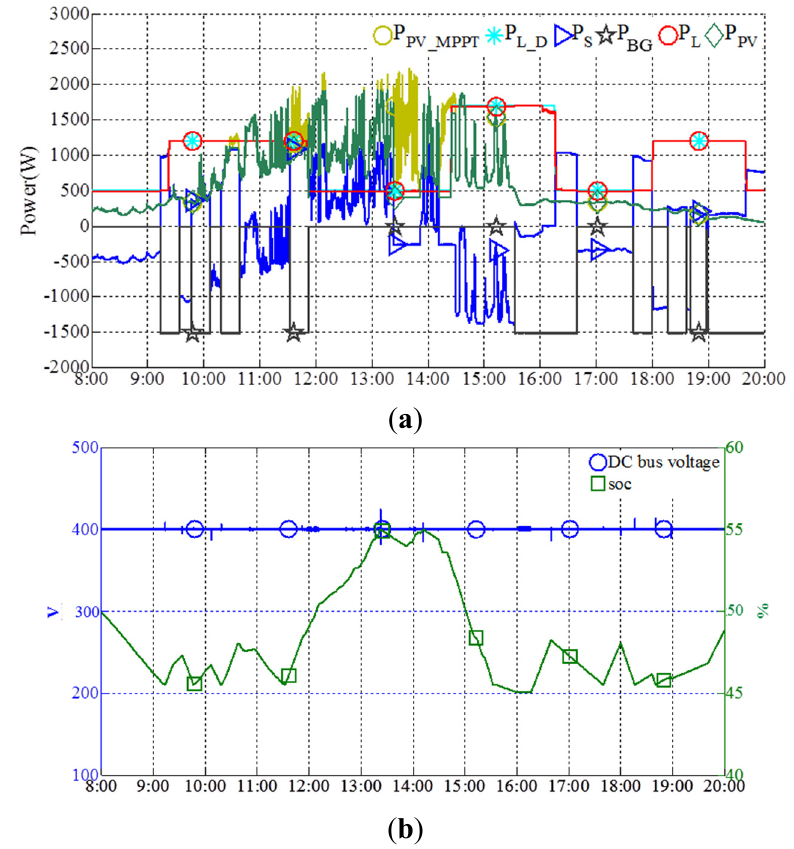
Figure 12. ( a ) Experimental real-time power flow for Test 2; ( b ) Experimental DC bus voltage and soc evolution for Test